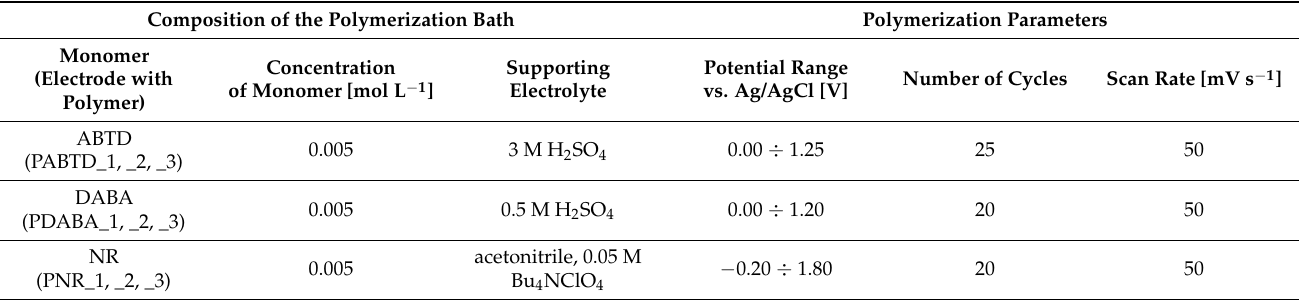
Table 1. Conditions for the preparation of three types of polymer films on Pt wire electrodes (n = 3). Composition of the Polymerization